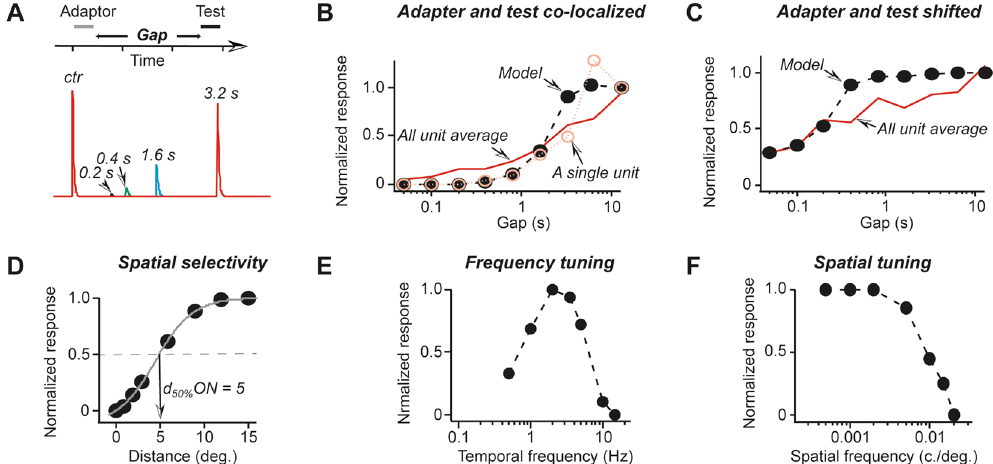
Figure 7. Simulations show profound effects of adaptation on visual responses of SC neurons to gratings. ( A ) An example of responses generated by the adaptation model. The stimulation protocol is shown above, the adaptor and the test stimuli were co-localized. Response traces for the following gap values are overlaid: 0.05 s, 0.1 s, 0.2 s, 0.4 s, 0.8 s, 1.6 s and 3.2 s. Only in the last 4 traces the test stimulus induced a response. ( B ) The summary of simulation results for co-localized adaptor and test stimuli as shown in A . Model response amplitude is plotted against gap duration (black filled circles). For comparison, the average data from all units is shown as a red line while data of a single unit, that are displayed in Fig. 4, are shown as light red open circles. ( C ) Simulation data for adaptor and test stimulus placed 14 degrees apart (black filled circles). Experimental data, the average of all units for adaptor and test stimuli set apart are shown as a red line. ( D ) Simulated response data for different distances between the adaptor and test stimuli inside RF are shown as black circles. A grey line is a Sigmoid function fit. ( E ) A plot of simulated response amplitude against the temporal frequency of gratings. The spatial frequency of all gratings was fixed at 0.01 c./deg. ( F ) A plot of simulated response amplitude against the spatial frequency of gratings. The temporal frequency of all gratings was 2